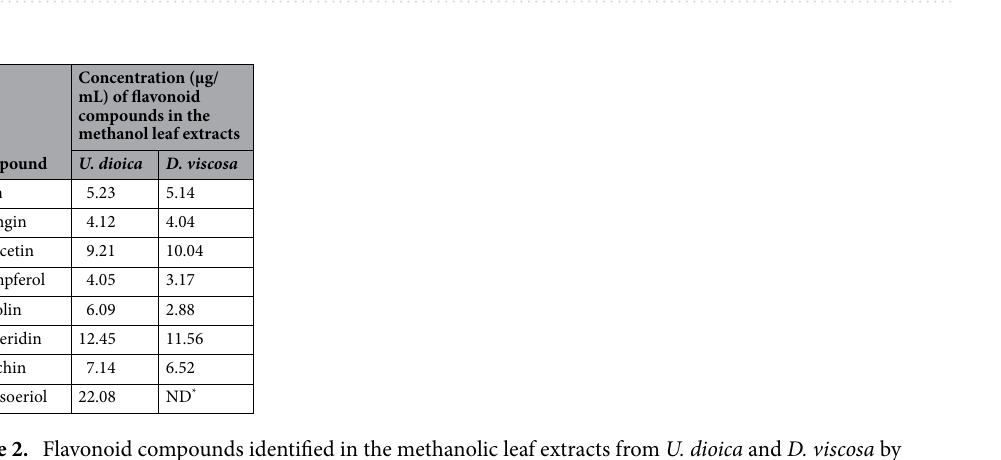
Table 2. Flavonoid compounds identified in the methanolic leaf extracts from U. dioica and D. viscosa by HPLC. * Not detected.